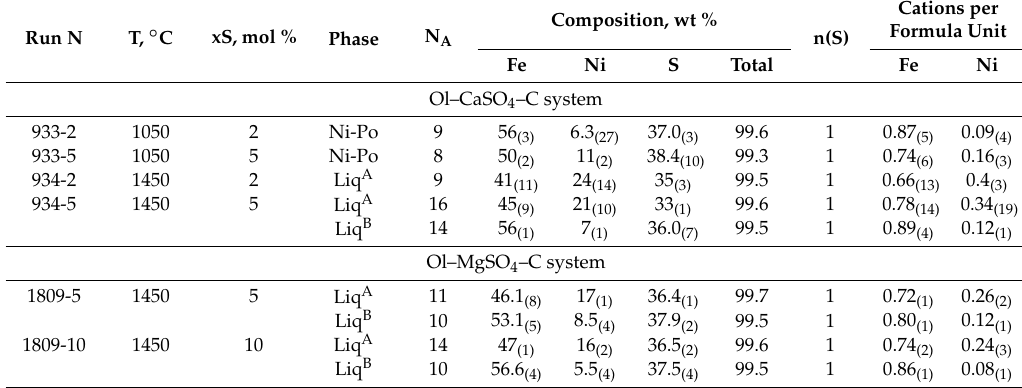
Figure 5. Temperature and sulfur content (xS) dependencies of Ni concentrations in sulfides and sulfide melts.